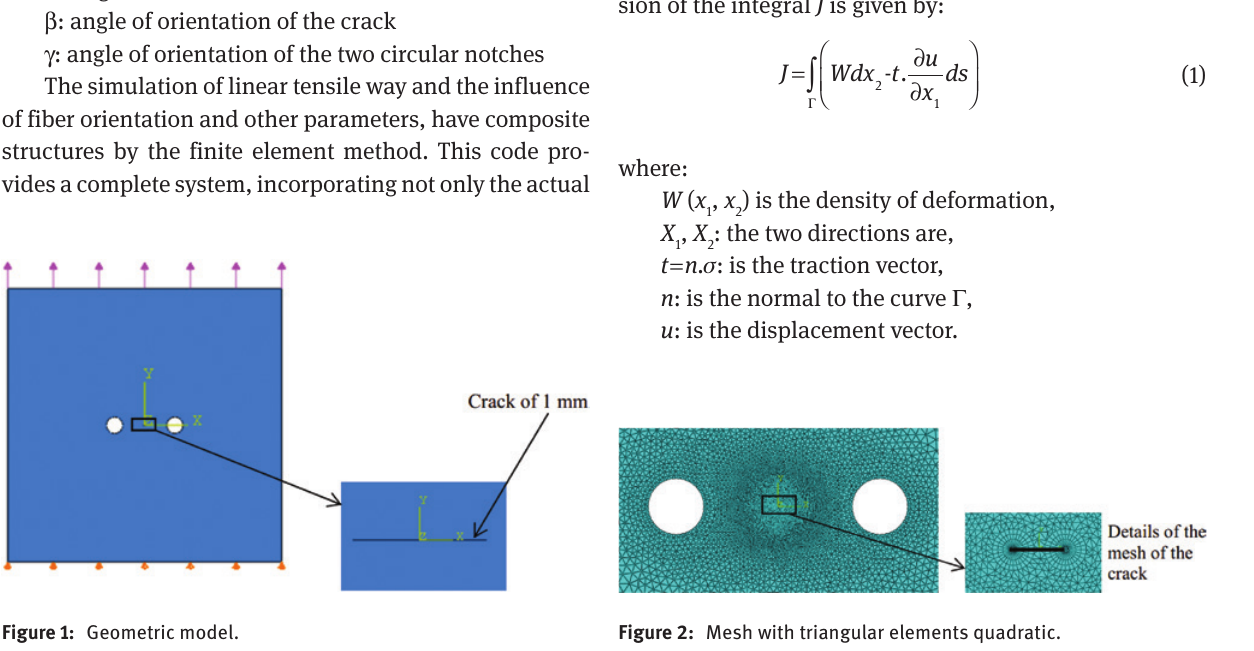
Figure 1: Geometric model. Figure 2: Mesh with triangular elements